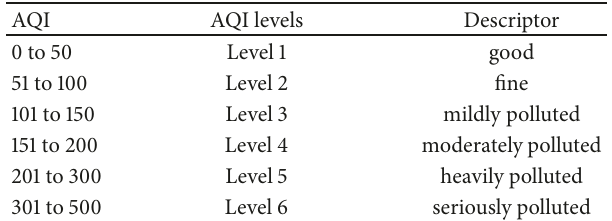
Table 1: AQI and health